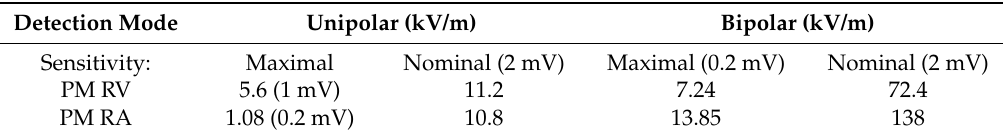
Table 8. Electric field threshold (in kV/m, 50Hz) summary for different sensitivity and detection